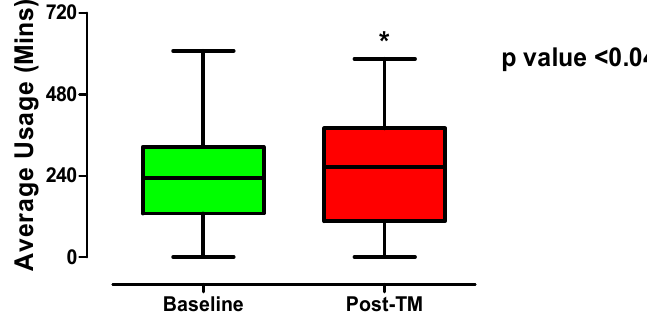
Figure 4. Average usage (in minutes) and compliance ( ≥ 4 h usage day %) pre- (30 days post-CPAP initiation) and 30 days post-telemonitoring intervention. Wilcoxon—Rank test was used to compare the group. * p value ≤ 0.05 was considered to be significant.